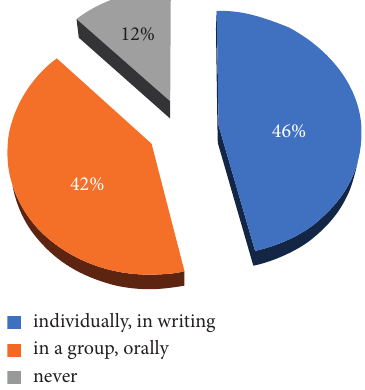
Figure 5: Creative thinking of students and the ability to freely express their thoughts in language